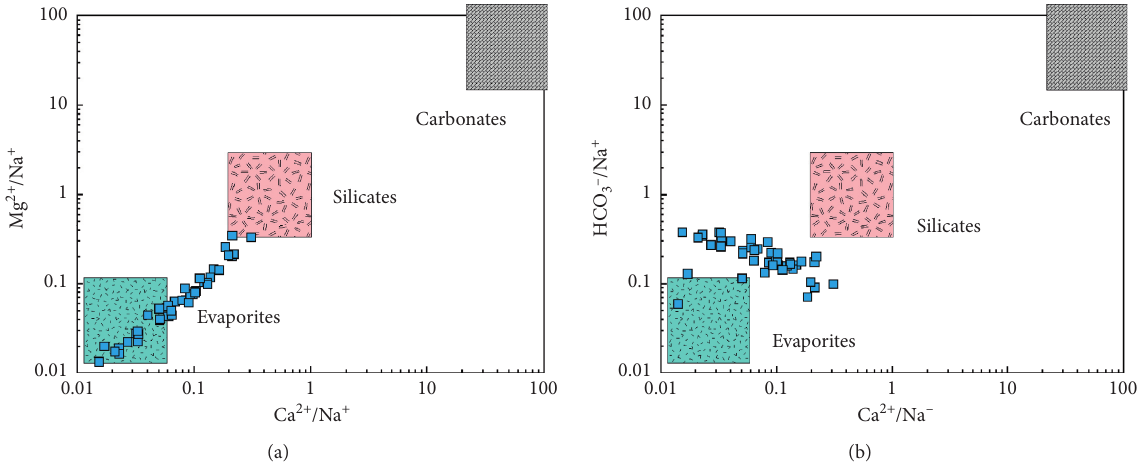
Figure 7: Scatter plots of (a) Na-normalized Ca versus Mg and (b) Na-normalized Ca versus HCO